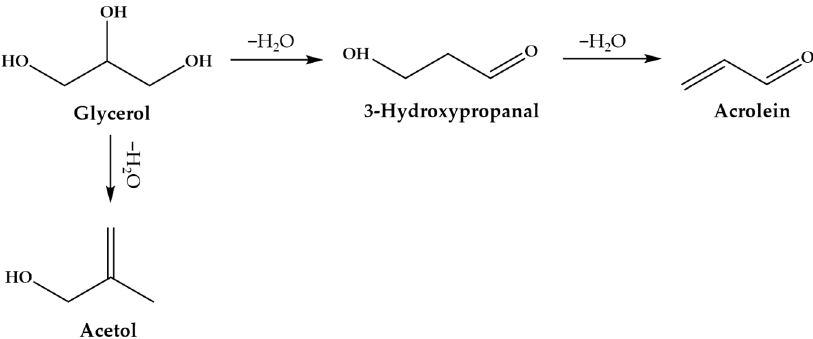
Figure 8. The reaction pathways for glycerol dehydration over a solid acid catalyst [63].